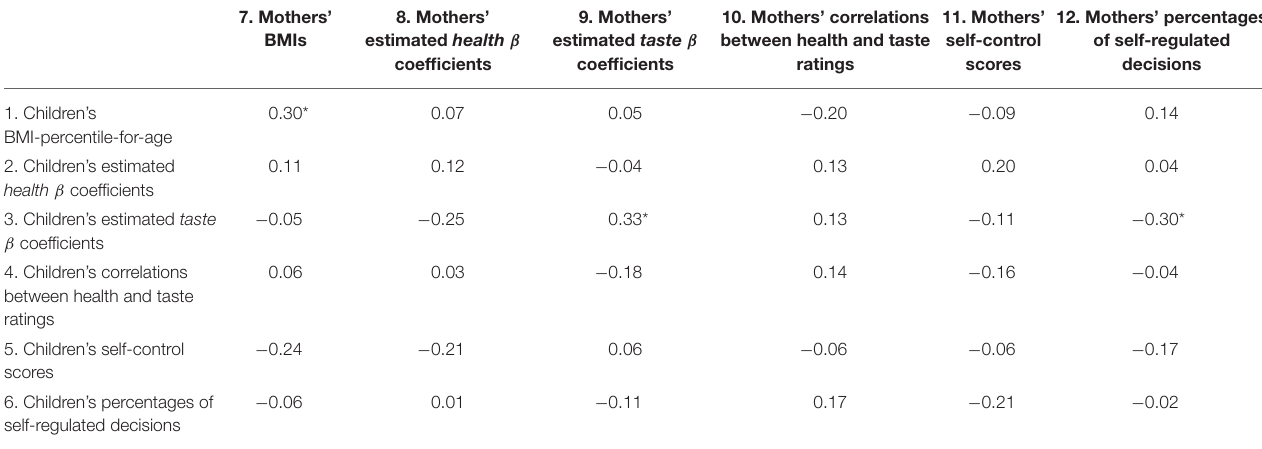
TABLE 4 | Correlations for dynamics of unhealthy food decision-making in mother-child dyads.